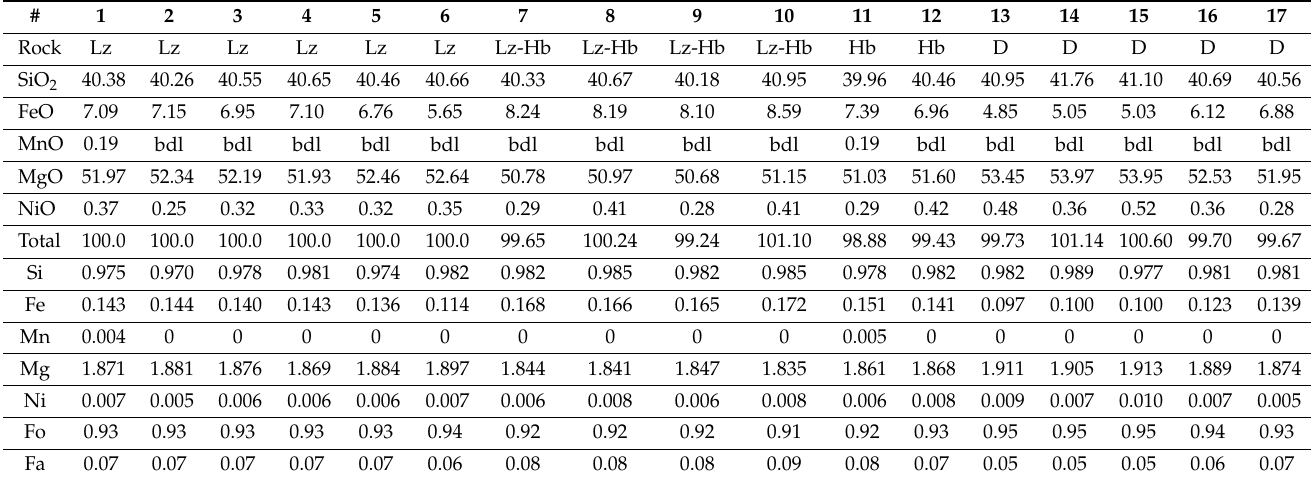
Table 2. Composition of olivine grains in peridotite of Kempirsay massif